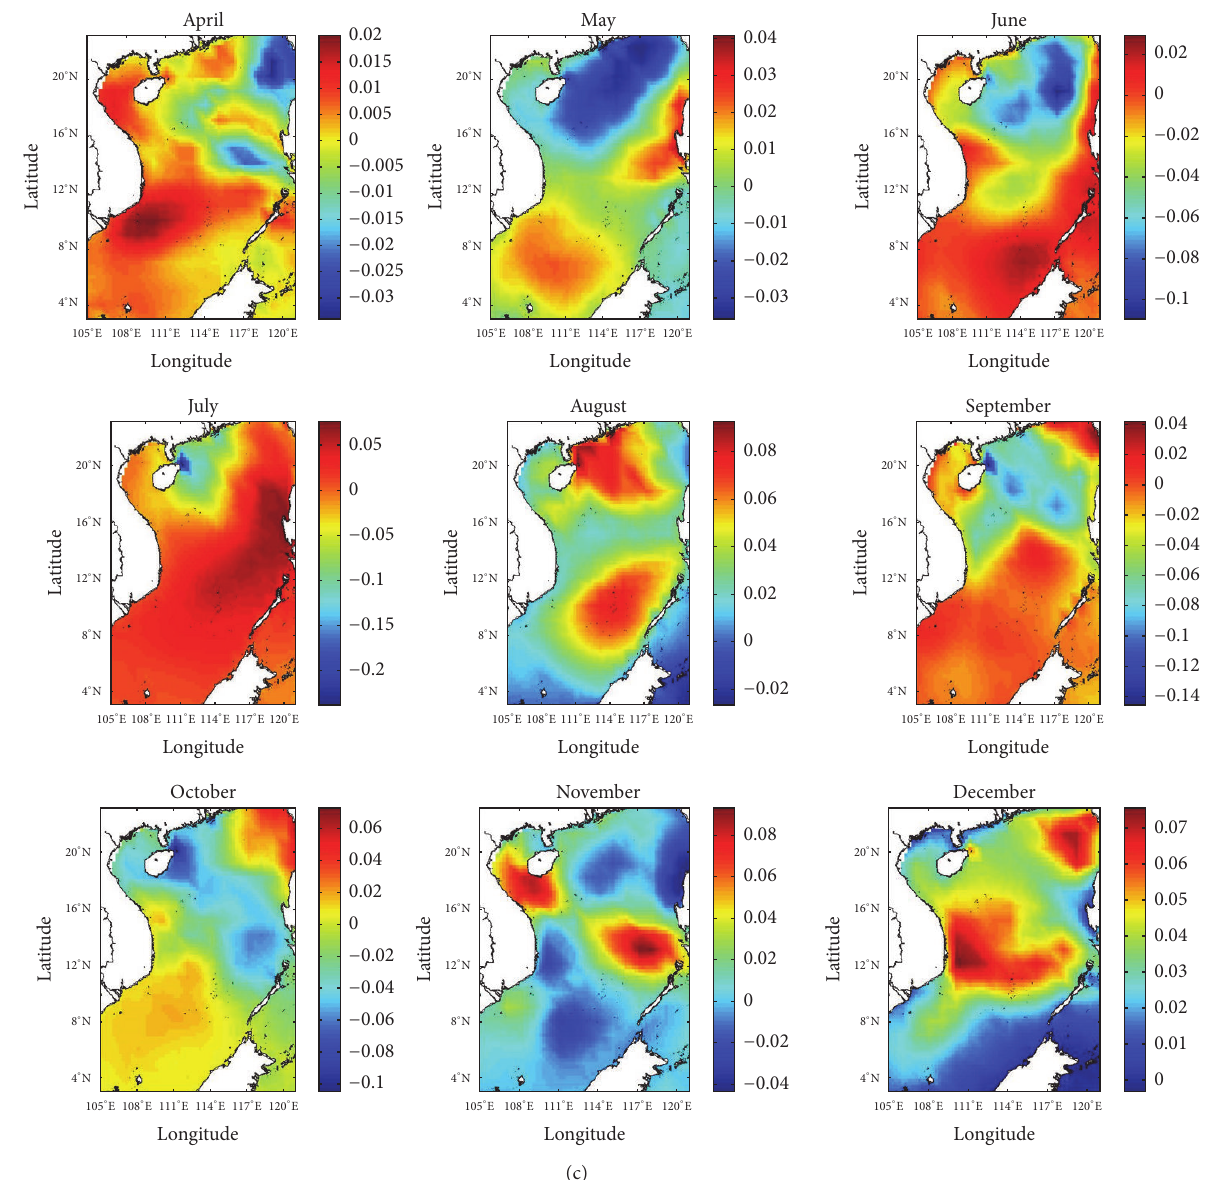
Figure 9: (a) Long-term trend of annual mean 99th-percentile SWH from year 1976 to year 2005. Unit:m yr −1 . Only trends significant at the 95% level are shown. (b) Long-term trends of seasonal mean 99th-percentile SWH from year 1976 to year 2005. Unit:m yr −1 . Only trends significant at the 95% level are shown. (c) Long-term trends of monthly mean 99th-percentile SWH from year 1976 to year 2005. Unit: myr −1 . Only trends significant at the 95% level are